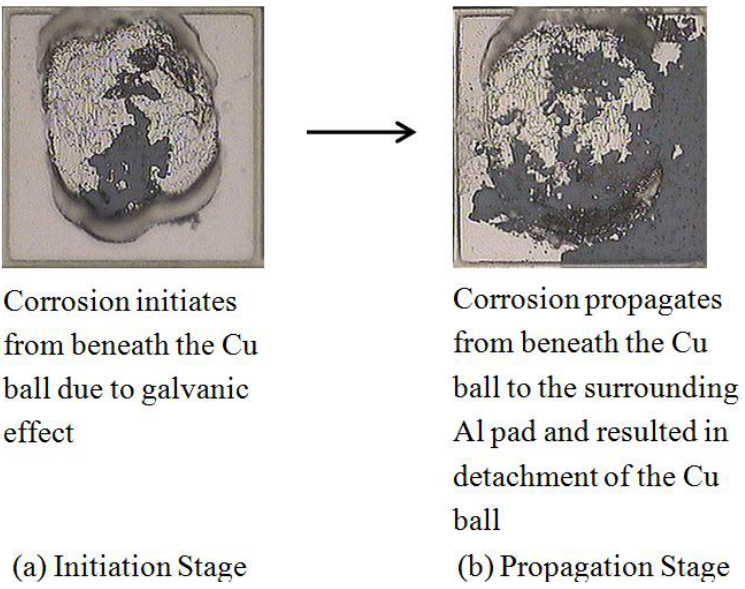
Figure 4. Corrosion mechanism of Cu balls and Al pads at ( a ) initiation and ( b ) propagation stage at 5 min soaking time.